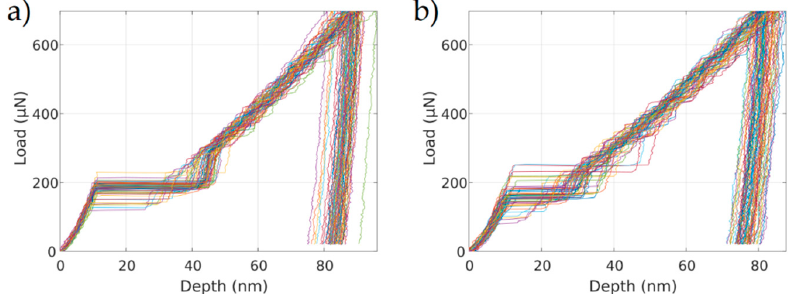
Figure 2. Load-displacement curves recorded with the fast loading rate ( a ) before charging and ( b ) after charging with hydrogen. Curves in which no pop-in could be detected were